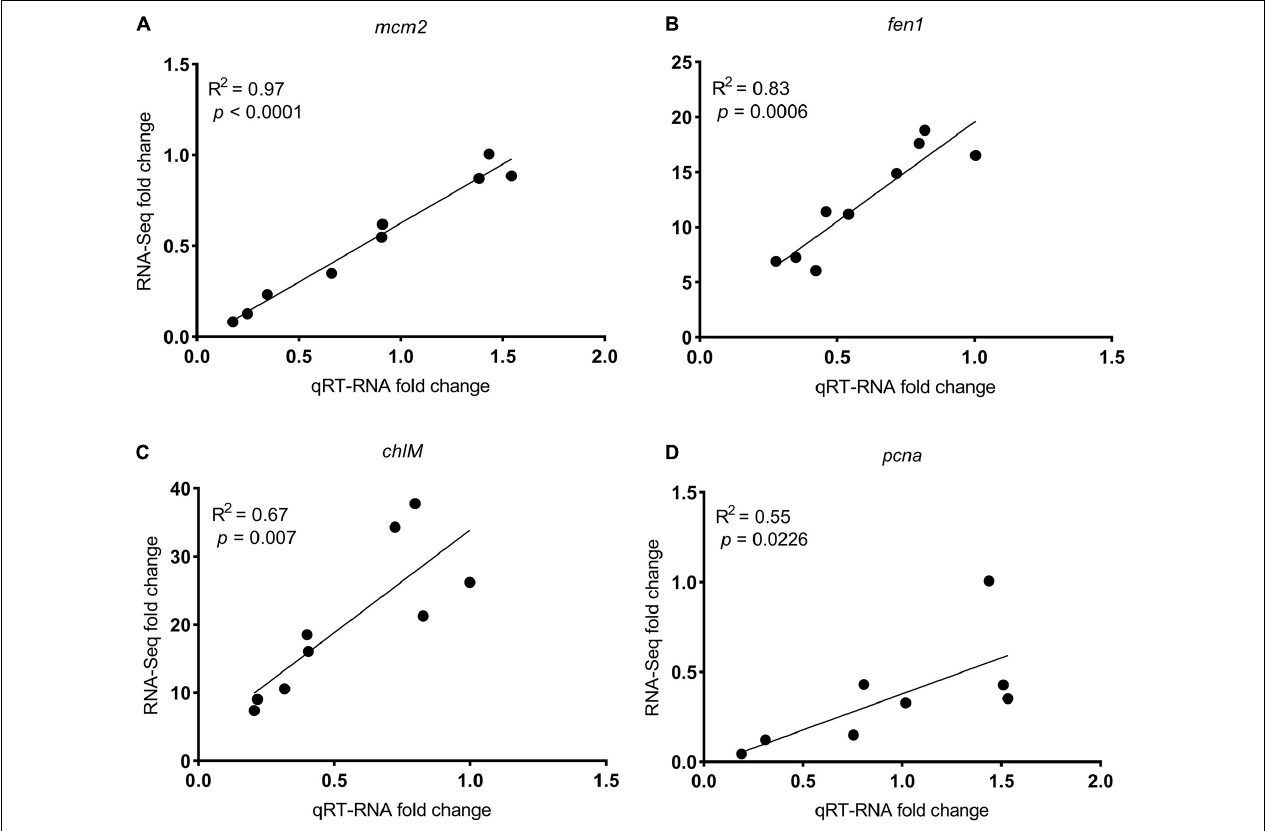
FIGURE 3 | The correlation between fold changes (SMX-treated groups relative to control) in mRNA levels determined by qRT-PCR and RNA-seq of genes (A) mcm2 , (B) fen1 , (C) chlM , and (D) pcna . mcm2 , DNA replication licensing factor MCM2; fen1 , flap endonuclease-1; pcna , proliferating cell nuclear antigen; chlM , magnesium-protoporphyrin O-methyltransferase.